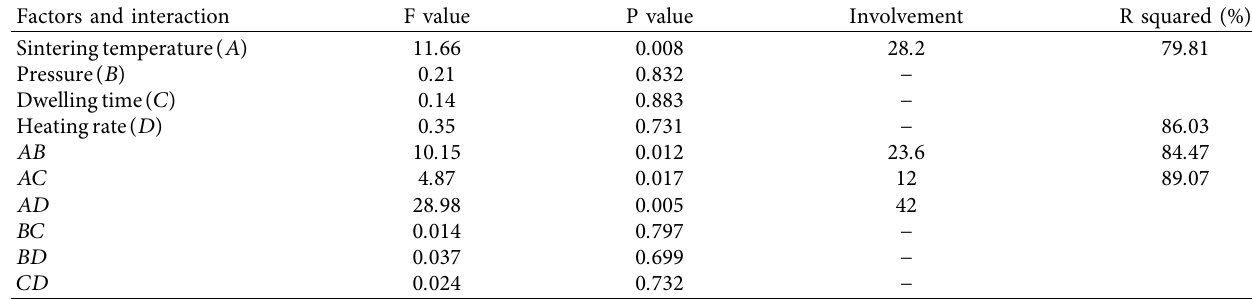
Table 4: ANOVA results on